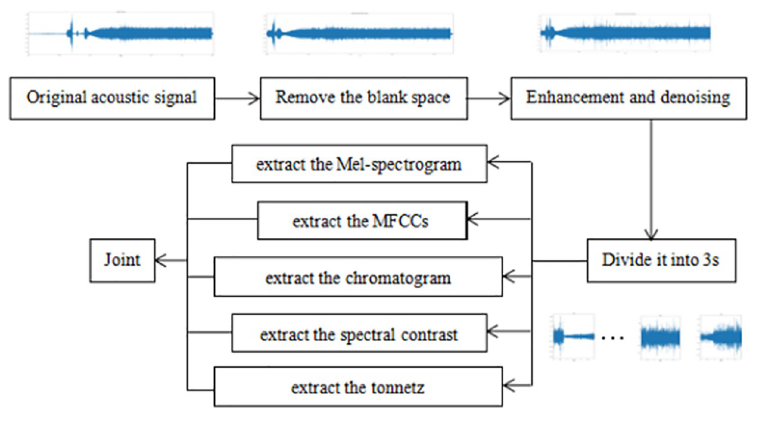
Fig 3. Data processing flow chart.